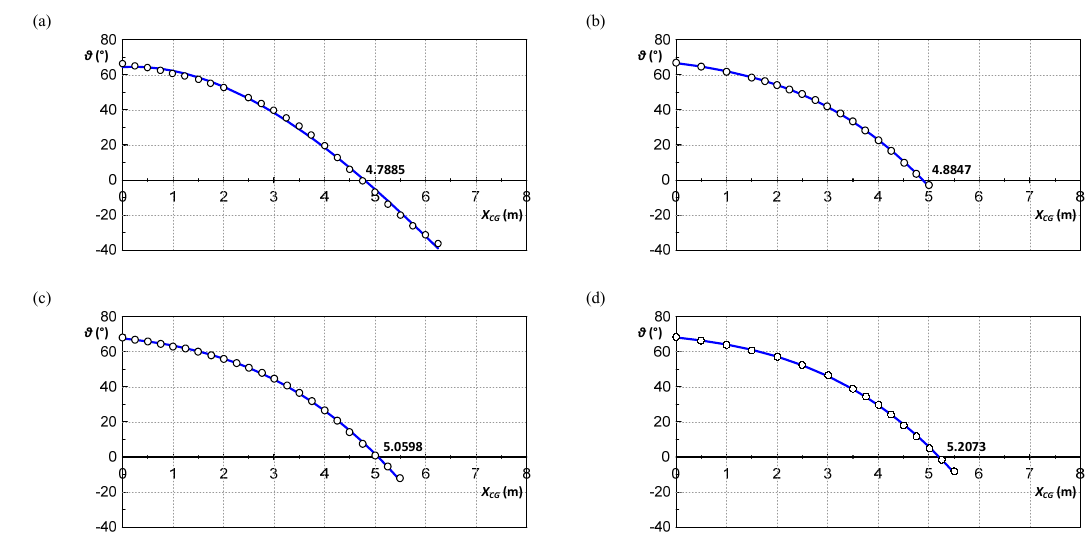
Figure 14. Variation of the pitch angle θ according to different values of X CG for each duct weight. ( a ) 90%; ( b ) 87.5%; ( c ) 85%; ( d ) 82.5% of the duct buoyancy.